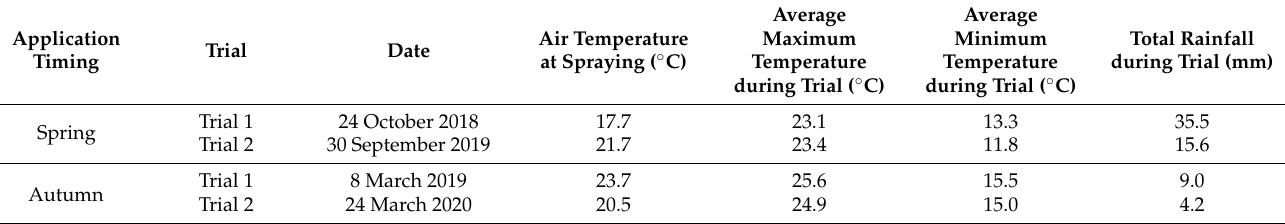
Table 1. Calendar dates and environmental conditions during herbicide application in field trials in 2018 − 2020.